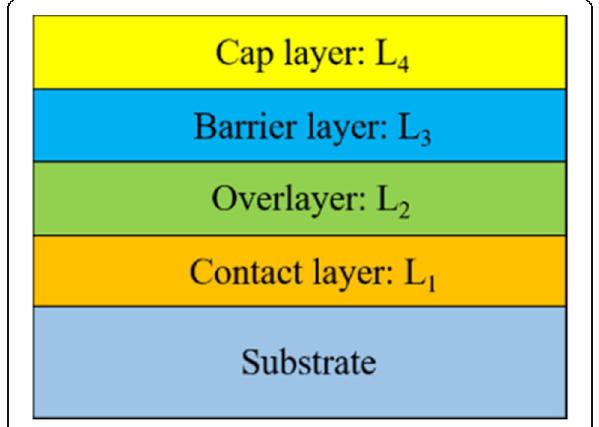
Fig. 10 The schematic of metal stacks for obtaining Ohmic contacts to wide-bandgap